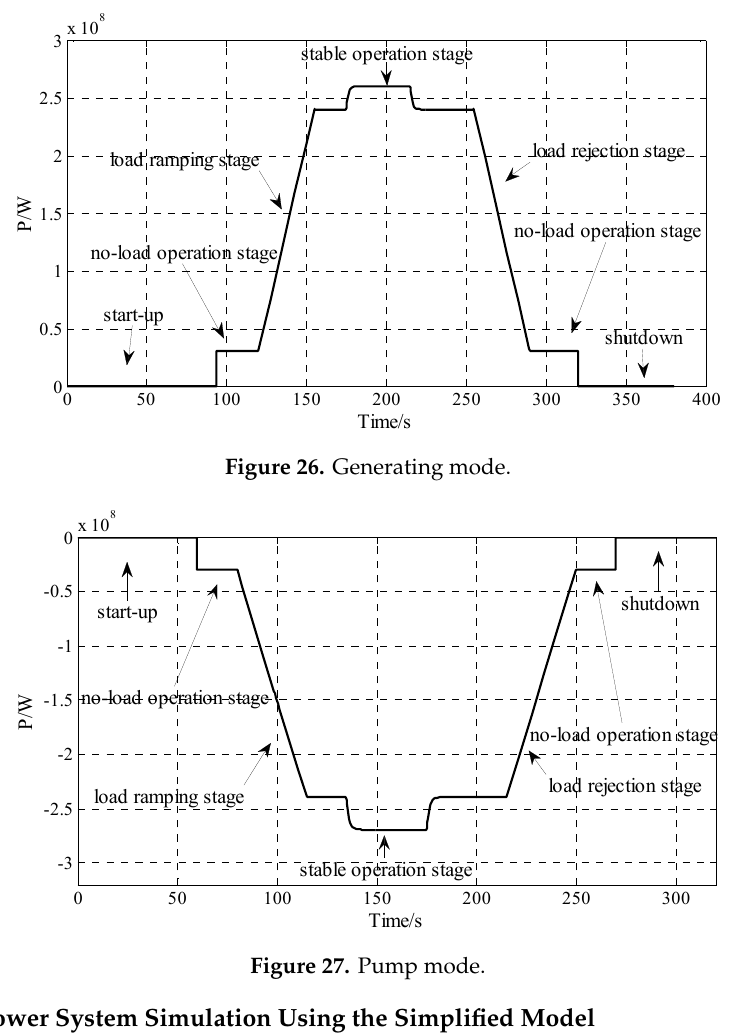
( b ) Figure 29. Simulation waveform in generating mode. ( a ) power flow on 18-kV bus; ( b ) the frequency of the system. At t = 10 s, G1 is started, and t = 10 s to t = 104 s is the start-up stage, t = 104 s to t = 130 s is the no load operation stage, t = 130 s to t = 165 s is the load increasing stage, and t = 165 s to t = 265 s is the